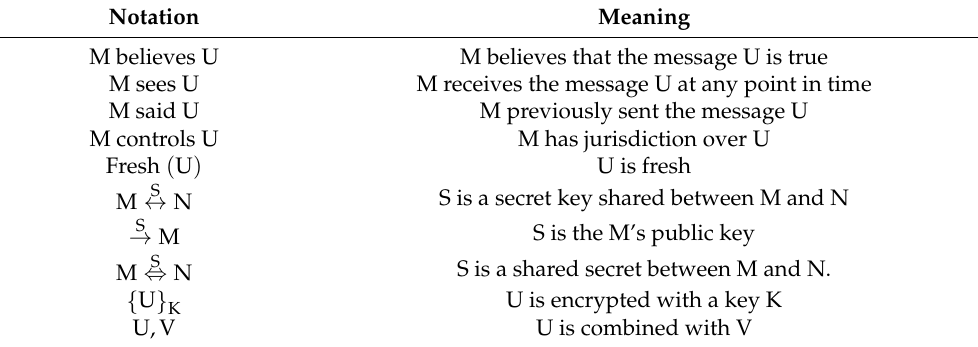
Table 1. BAN logic